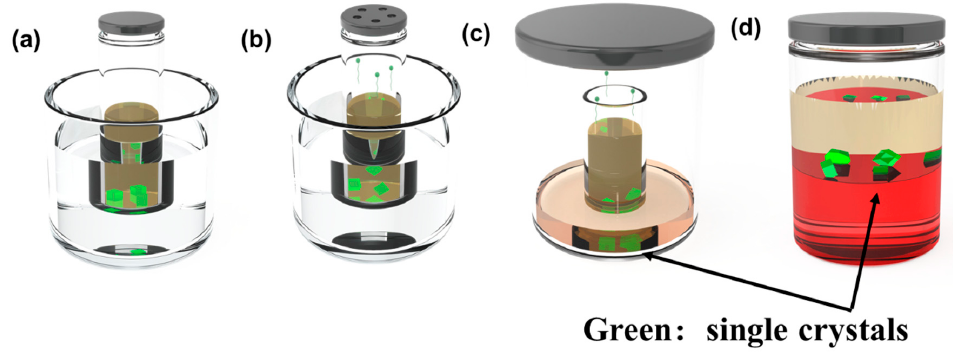
Figure 3. Solution-based methods for the single-crystal growth of organic charge-transfer cocrystals (CTCs): ( a ) slowing cooling method; ( b ) slow solvent evaporation method; ( c ) vapor di ff usion method; ( d ) liquid-liquid interface di ff usion method.